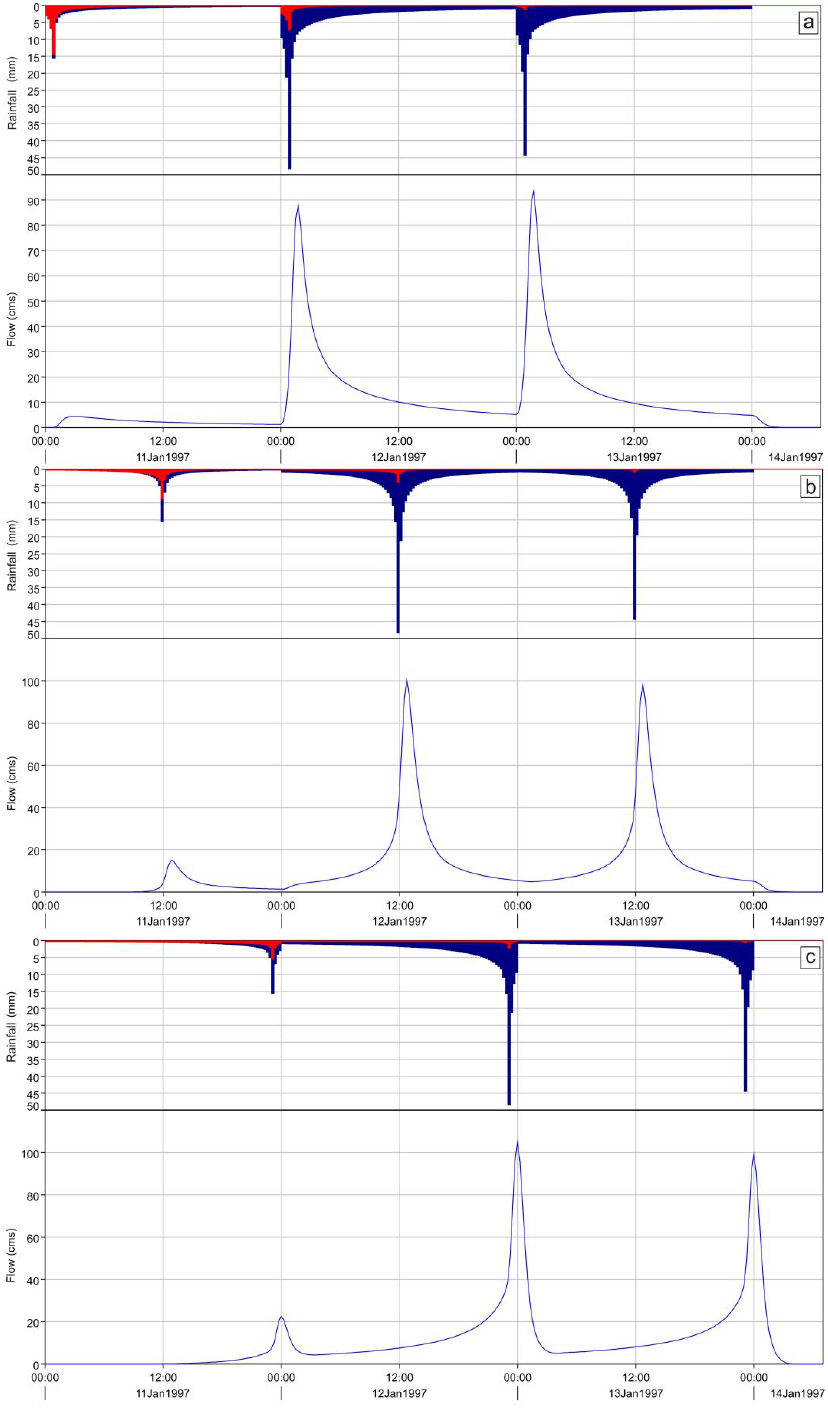
Figure 5. Rainfall — runoff graph for the three simulated rain scenarios: left skewed ( a ); symmetric ( b ) and right skewed ( c ). The different hydrological response of the basin in runoff generation is shown.